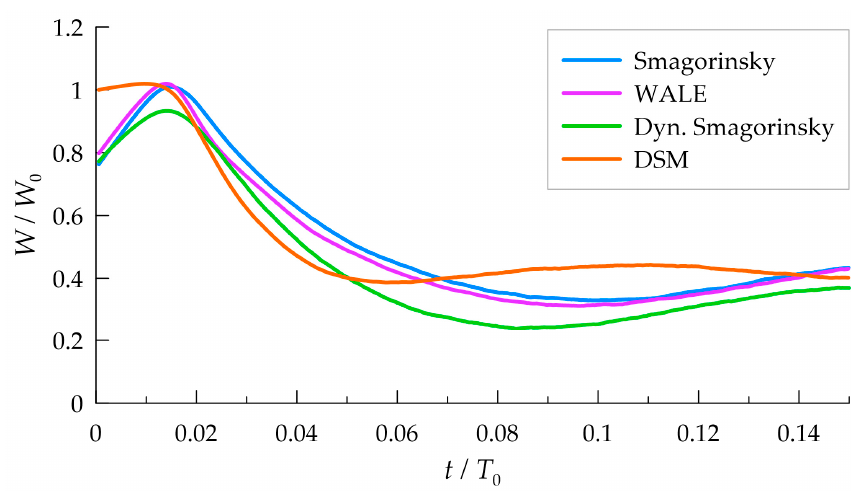
Figure 6. Fuel-consumption